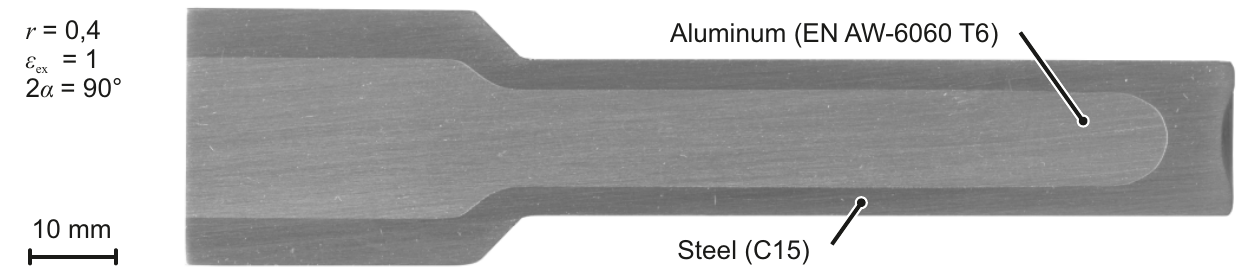
Figure 2. Composite shaft, produced by forward rod extrusion of a backward can extruded steel shaft with an aluminum core, according to [9].